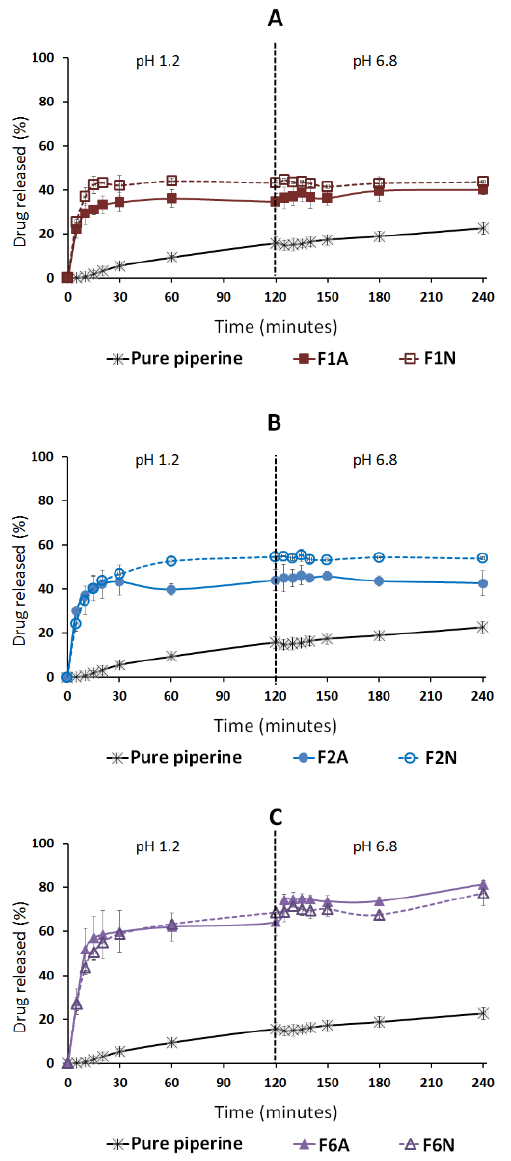
Figure 13. Influence of adsorbent type on piperine release from solid SNEDDS. ( A ) Denotes F1, ( B ) F2 and ( C ) F6 solidified SNEDDS. The dashed line indicates the time point at which the dissolution media was shifted from pH 1.2 to pH 6.8. Data are expressed as mean ± SD. Details of the formulation compositions are presented in Table 6.